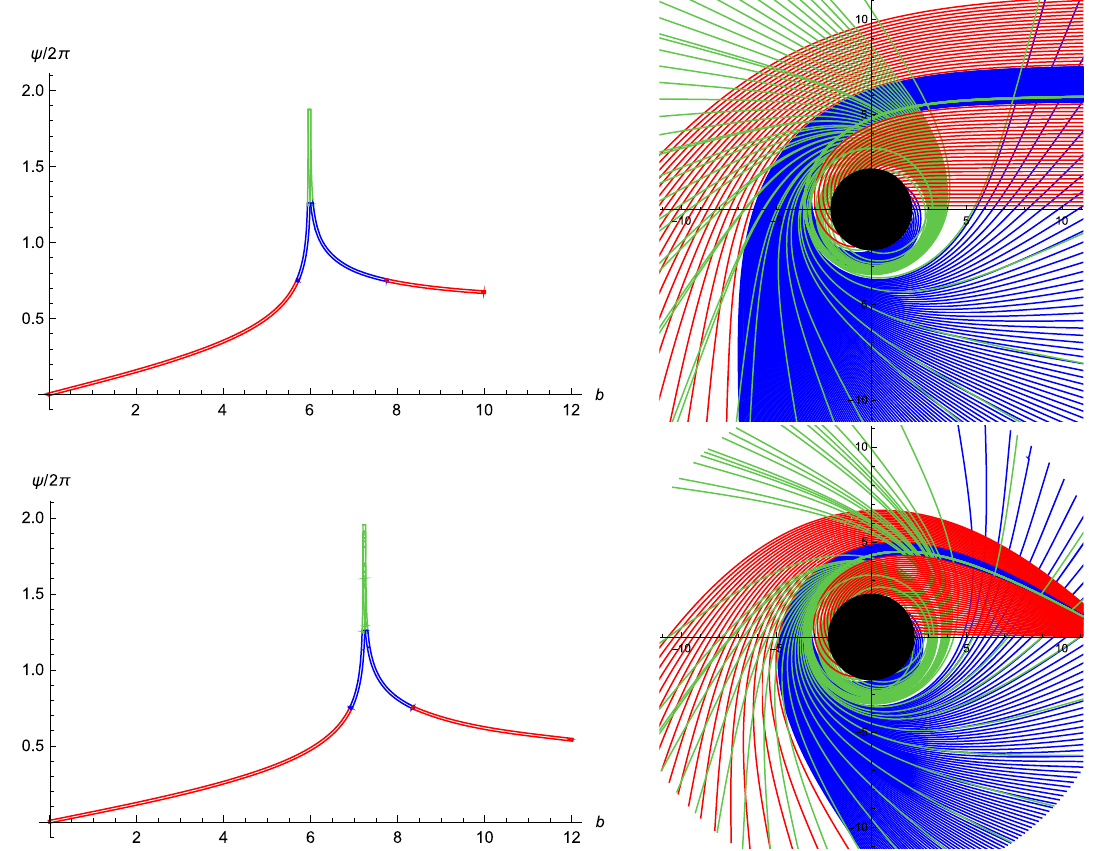
Fig. 3 Behaviorofphotonsinthequintessenceblackholeasafunction of impact parameter b with M = 1, a = 0 . 05, w = − 0 . 5 (top row) and w = − 0 . 7 (bottom row). (Left column) We show the fractional number of orbits, n = ψ/ 2 π , where ψ is the total change in azimuthal angle outside the horizon. The direct, lensing and photon ring corre- spond to n < 3 / 4 (red), 3 / 4 < n < 5 / 4 (blue), and n > 5 / 4 (green),